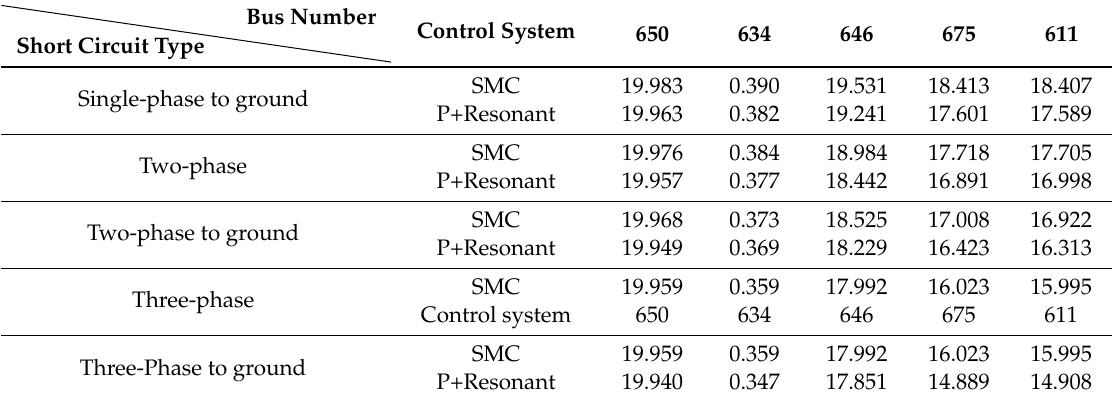
Figure 8. Voltage domain variations in bus 611 due to symmetrical short circuit faults in bus 671 and compensation with P+Resonant and SMC control systems. Table 2. Domain of bus voltage due to different short circuits in the DSTATCOM-compensated system.